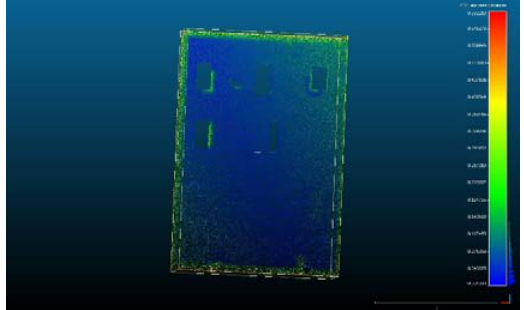
Figure 13: Discrepancy map between the UAV Photoscan processing and UAV VisualSfM